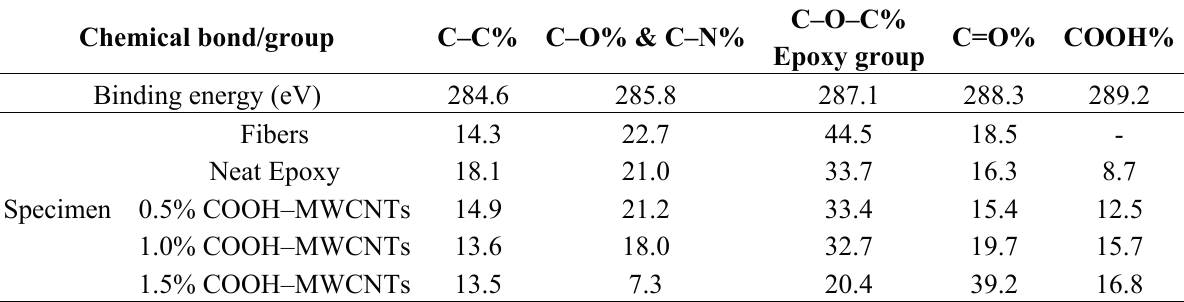
Figure 15. XPS analysis showing the deconvolution of binding energies of carbon C1 peaks for ( a ) a carbon fiber fabric sample, ( b ) a 0.0 wt%, ( c ) 0.5 wt%, ( d ) 1.0 wt%, and ( e ) 1.5 wt% MWCNTs sample. Table 2. C1s peak fitting results for specimens with different MWCNTs